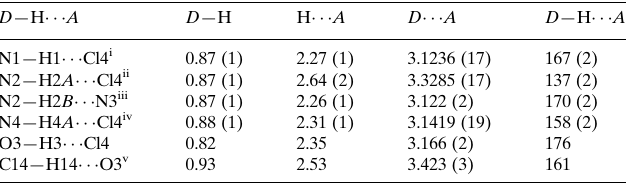
Hydrogen-bond geometry (A˚ , (cid:4)